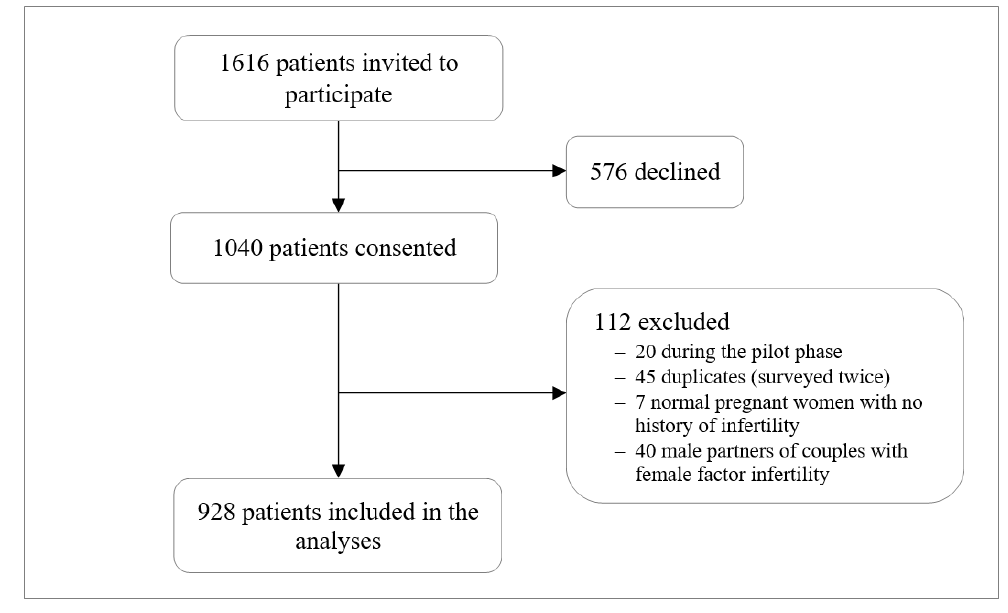
Figure 1. Flow chart of the surveyed fertility clinic attendees. Table 1. Sociodemographic characteristics of fertility clinic attendees, and the distribution between primary and secondary infertility.